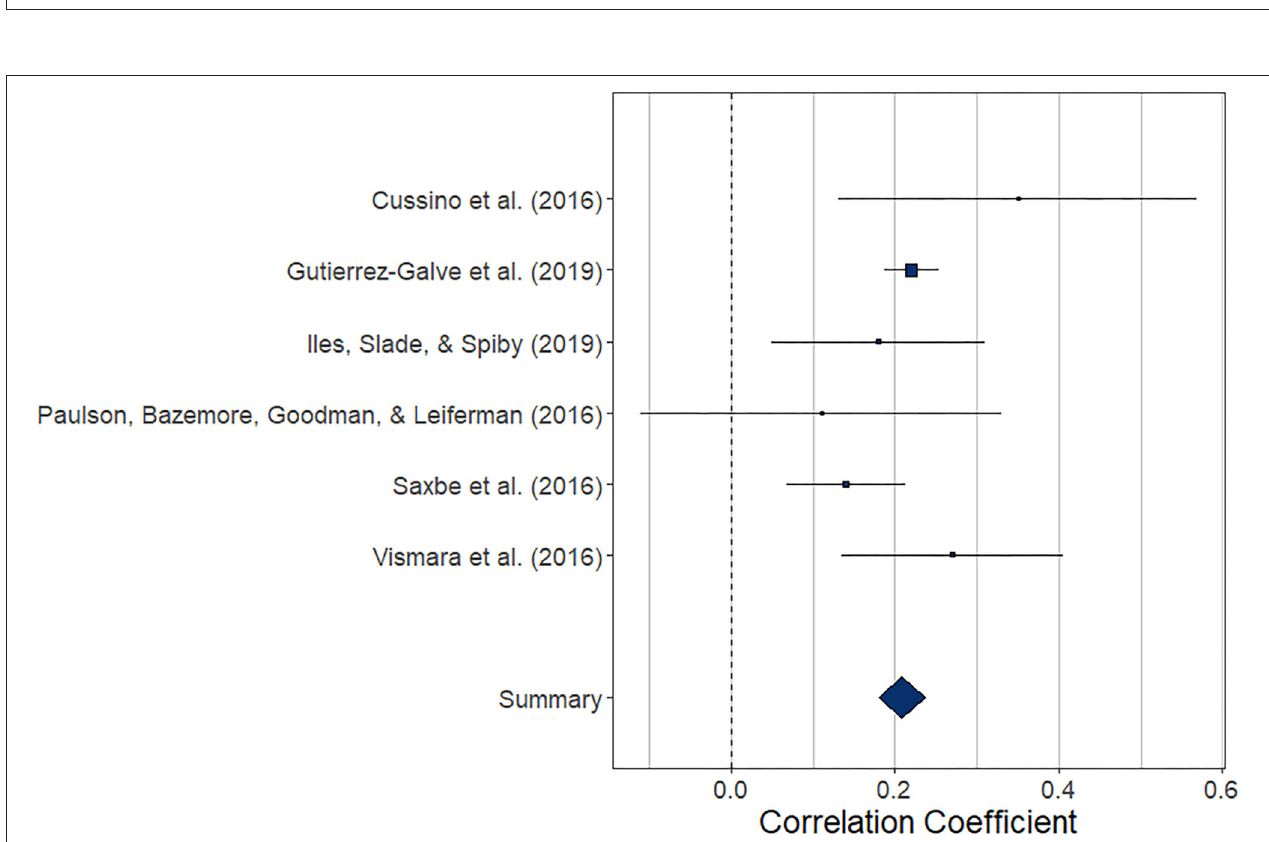
FIGURE 8 | Forest plot of the analysis of the prospective association between maternal depression at one timepoint and paternal depression at a later timepoint during the perinatal period. Weighted effect size and 95% CI are presented on the right.